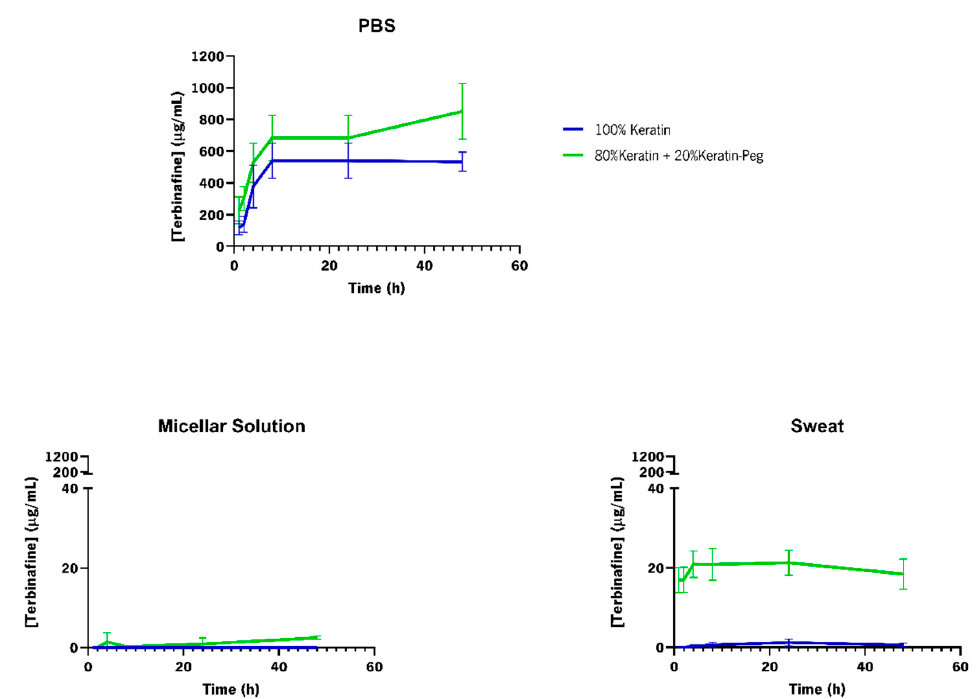
Figure 7. Terbinafine cumulative controlled release profiles from functionalized cotton fabrics with keratin-based particles encapsulating terbinafine. The release was performed under different conditions (against PBS (pH 7.4), micellar solution and acidic sweat solution (pH 4.3)), 100% keratin-Terb particles (blue), and 80% keratin/20% keratin-PEG-Terb (green).